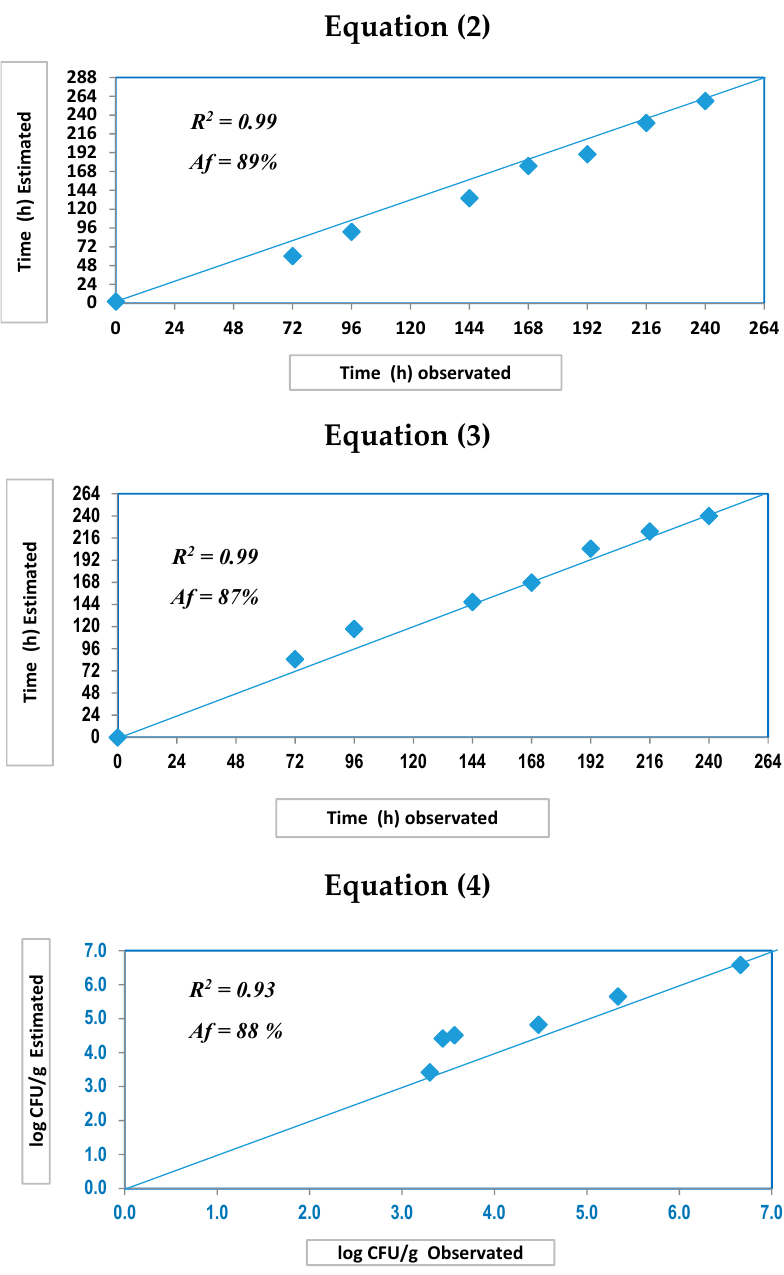
Figure 4. Estimated vs. observed plots for practical validation (Equations (2)–(4)) for seabream over the storage time in ice. Af (%): accuracy factor.